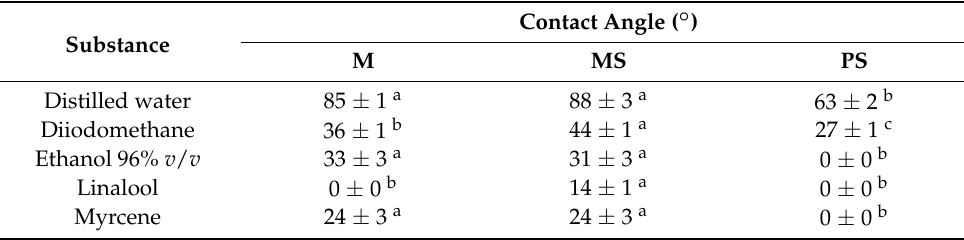
Table 2. Contact angle ( ◦ ) of the PET-supported (MS) and non-supported (M) membranes and the sup- port layer (PS) for distilled water, diiodomethane, ethanol 96%, linalool, and myrcene (CV = 5.93%). Contact Angle ( ◦ ) Substance M MS PS Distilled water 85 ± 1